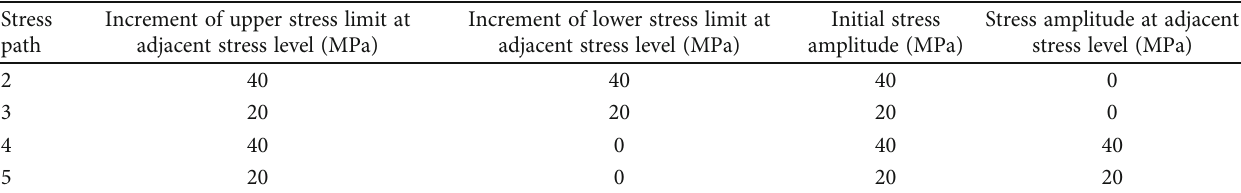
Figure 3: Loading diagram of di ff erent stress paths. Table 1: Loading parameters of each stress